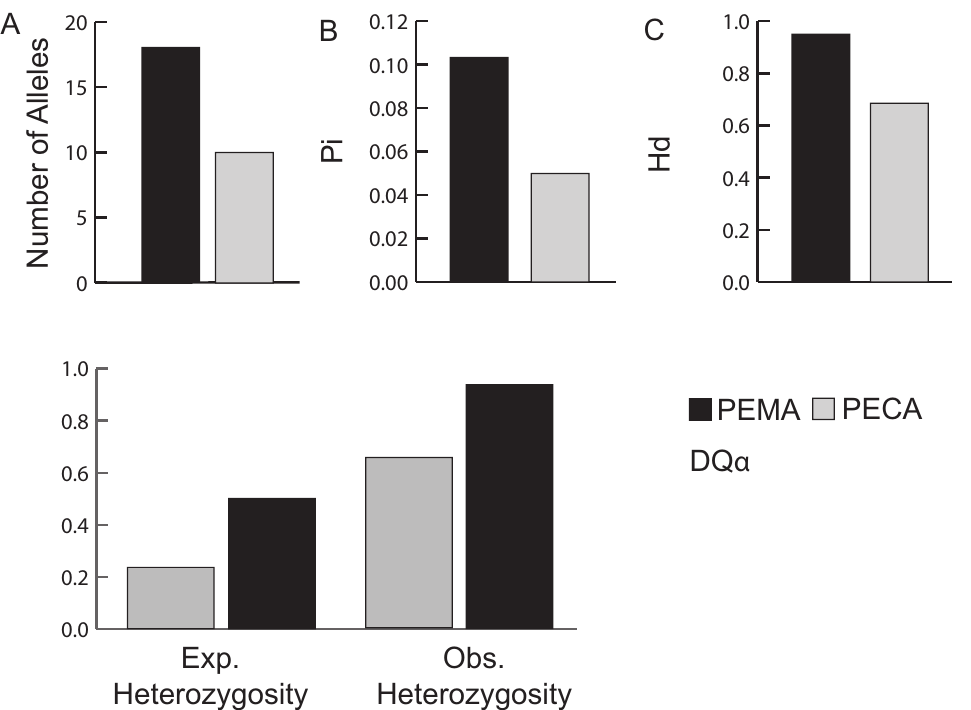
Figure 1. Comparisons of variability at the DQ a locus. A. Number of alleles detected for each species. B. Estimated values for Pi for each species. C. Estimated values for haplotype diversity for each species. D. Observed and expected values of heterozygosity in both species. For both species, Hardy-Weinberg tests resulted in values of P=0.000. In all cases, indices are greater for P. maniculatus than for P. californicus .